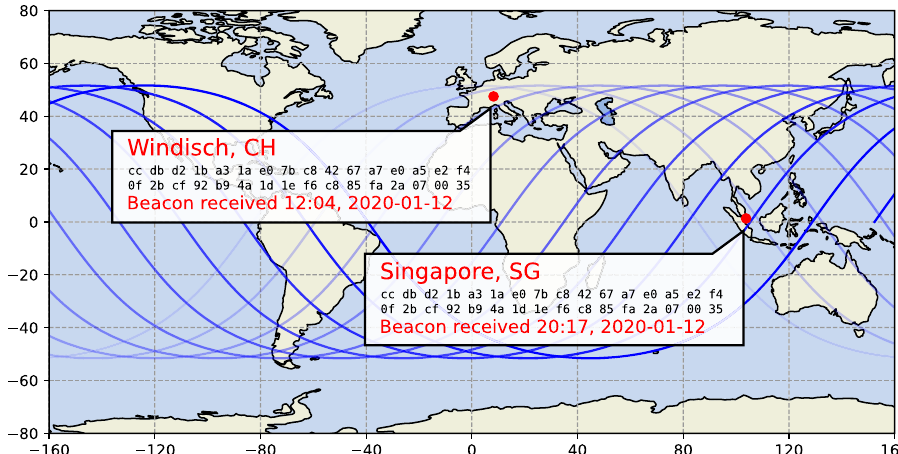
Fig. 4 Randomness beacon demonstration. We demonstrate a prototype orbiting randomness beacon. The ground track of our satellite is plotted against the world map, indicating the locations of our ground stations in Windisch (Switzerland) and Kent Ridge (Singapore). With an inclination of 51.6 ∘ and an orbital period ~90 minutes, the satellite is able to communicate with both ground stations 10 times within a 24-hour period. As our prototype randomness beacon updates every 24 hours, we are able to con fi rm the reception of identical beacons at both locations. Map graphics were generated using Cartopy 43 with public domain data from Natural Earth.